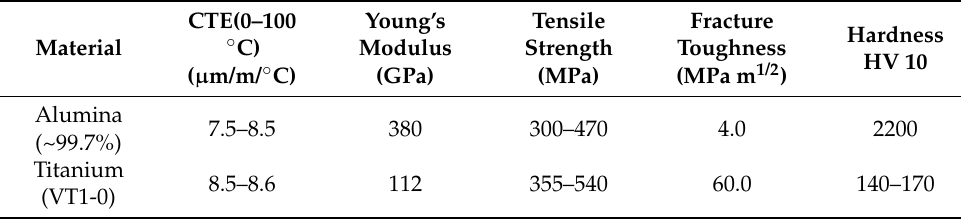
Table 2. Selected properties of the materials, according to the manufacturers’ data and